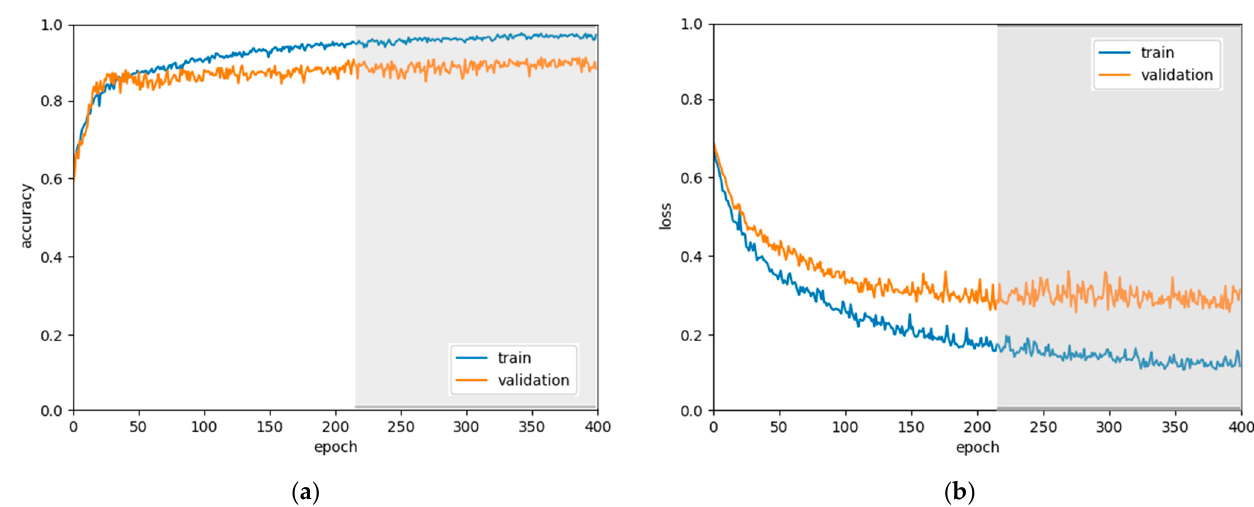
Figure 6. Training process of CNN3-CC-ECG network run over 400 epochs, showing the accuracy ( a ) and loss ( b ) curves for the training and validation dataset. The best model (validation accuracy → max) was achieved in 213 epochs. Further training epochs were discarded as being ineffective (gray area).